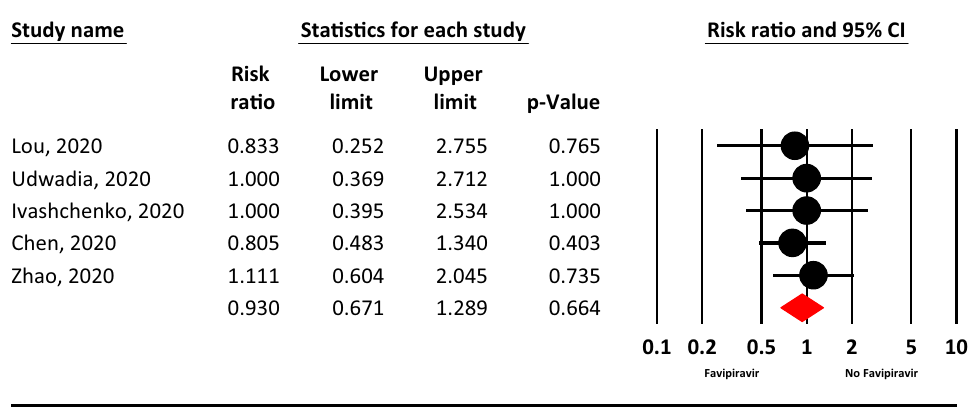
Figure 4. The meta-analysis of requiring supplemental oxygen therapy of Favipiravir on COVID-19 patients (red diamond: summery of total).